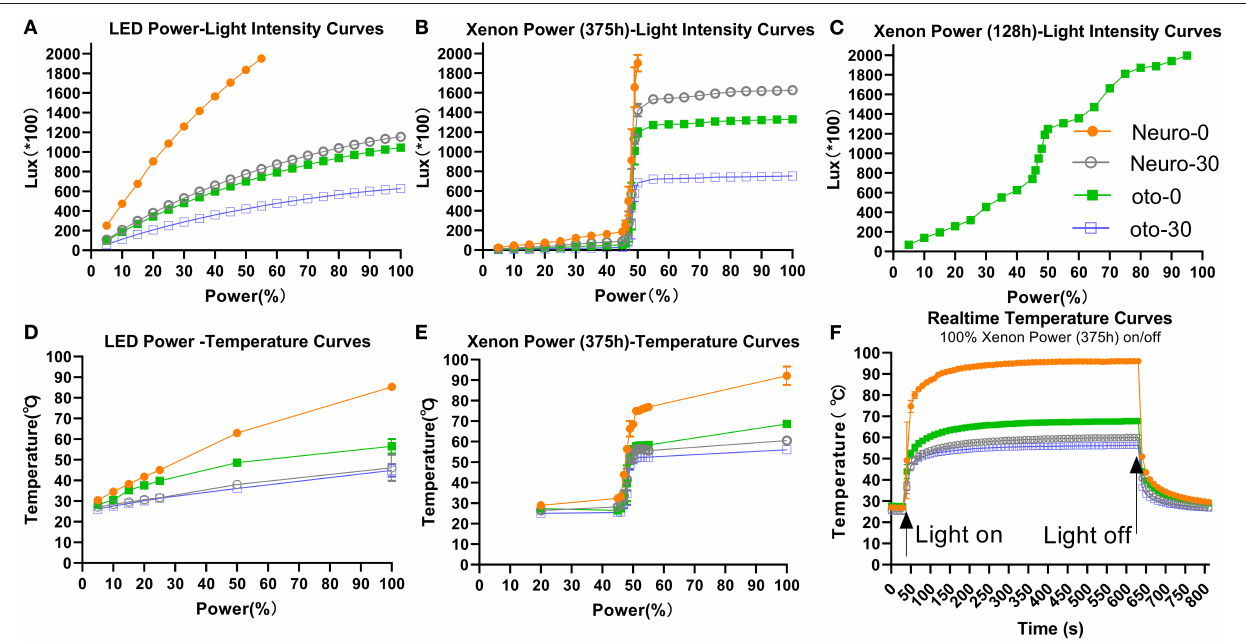
FIGURE 2 | Light intensity (A–C) and temperature (D–F) changes with various endoscopes using different LED or xenon light source power settings. (A) The fitting equations of the power-light intensity curves are as follows: Neuro-0: y = − 0.2533x 2 + 49.16x + 9.507, R 2 = 0.9999; Neuro-30: y = − 0.07455x 2 + 18.61x + 31.53, R 2 = 0.9996; Oto-0: y = − 0.06736x 2 + 16.83x + 28.61, R 2 = 0.9996; Oto-30: y = − 0.04046x 2 + 10.11x + 17.65, R 2 = 0.9996. (D) The fitting equations of the power-temperature curves are as follows: Neuro-0: y = − 0.002671x 2 + 0.8610x + 25.94, R 2 = 0.9980; Neuro-30: y = − 0.0007388x 2 + 0.2805x + 25.52, R 2